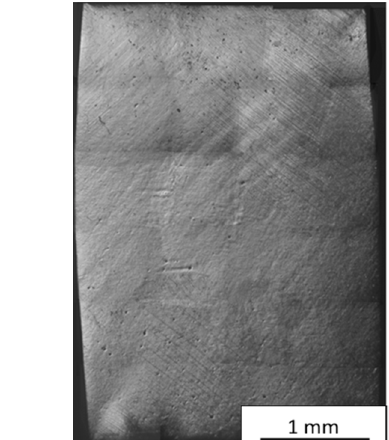
Figure 14. Deformation patterns in a simulated <001> Ni single crystal with {100} lateral faces: ( a ) h/d=2, ε =27%; ( b ) h/d=1, ε =22%.